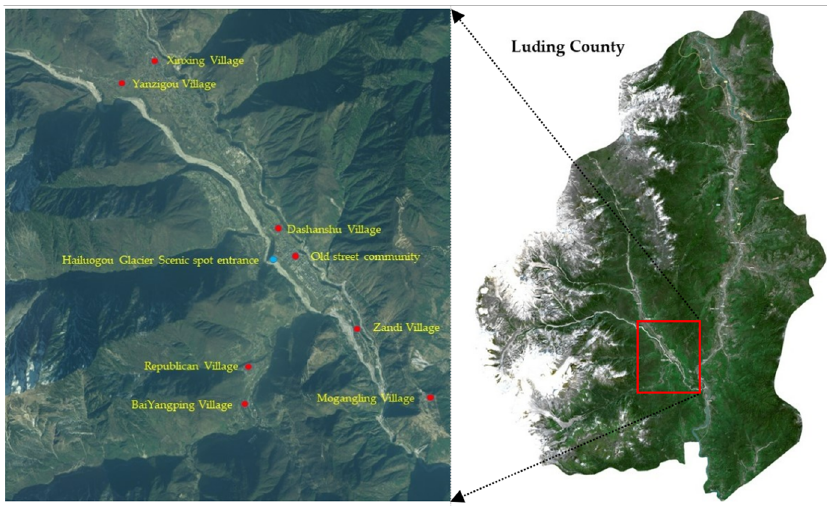
Figure 2. Location map of Hailuogou Glacier Forest Park.